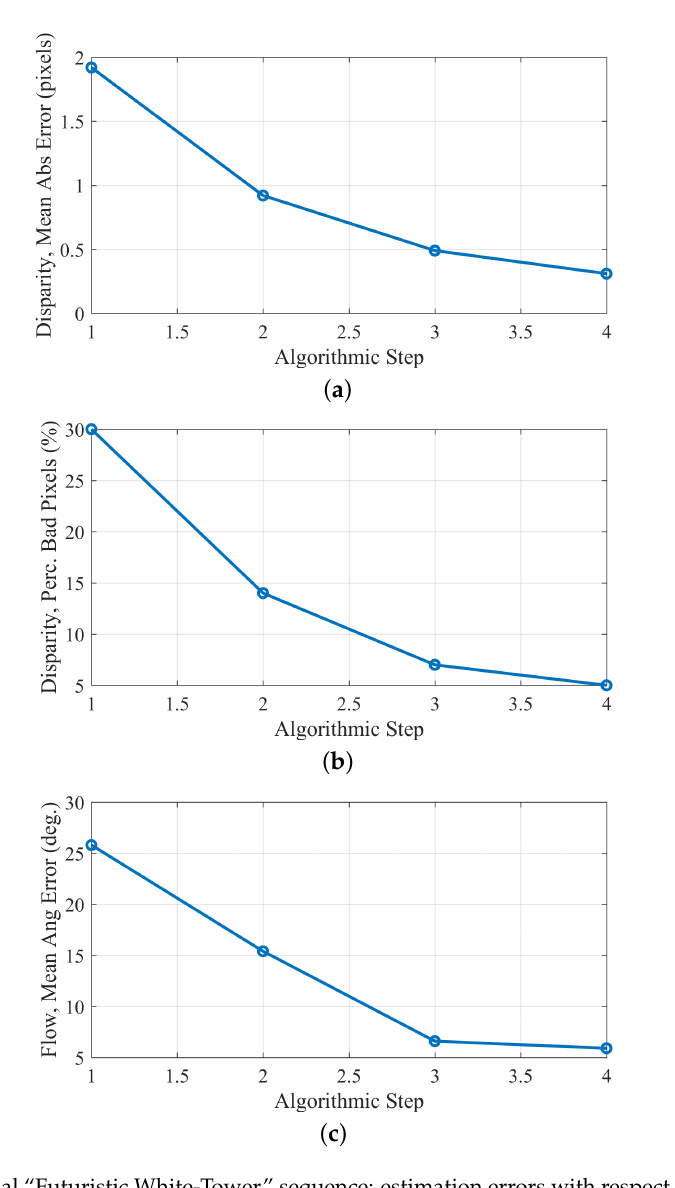
Figure 5. Artificial “Futuristic White-Tower” sequence: estimation errors with respect to the step of the algorithm: ( a ) mean absolute disparity error; ( b ) percentage of bad pixels; ( c ) flow mean angular error, after the application of each algorithmic step.